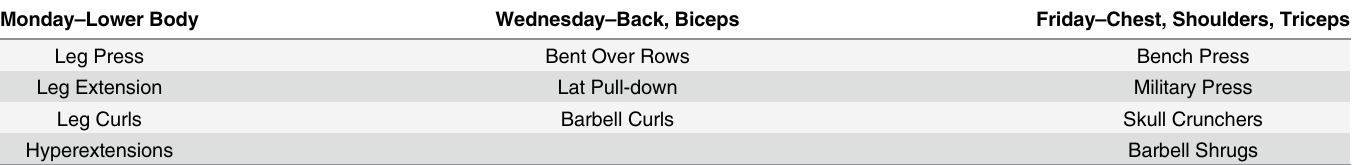
Table 1. Schematic of 8-week resistance training regimen in